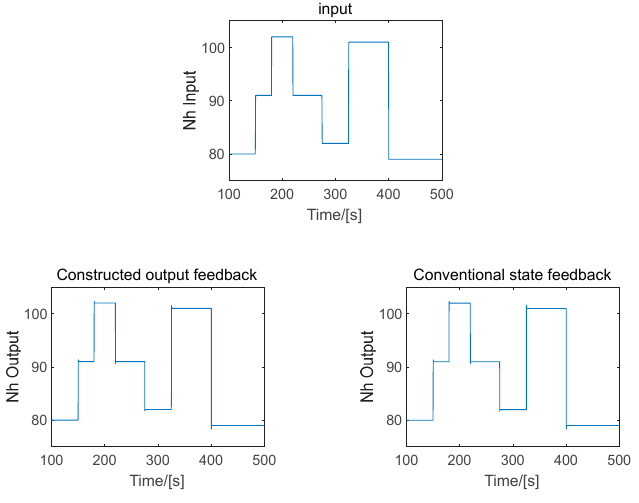
Figure 7. High-pressure rotor speed response curve.